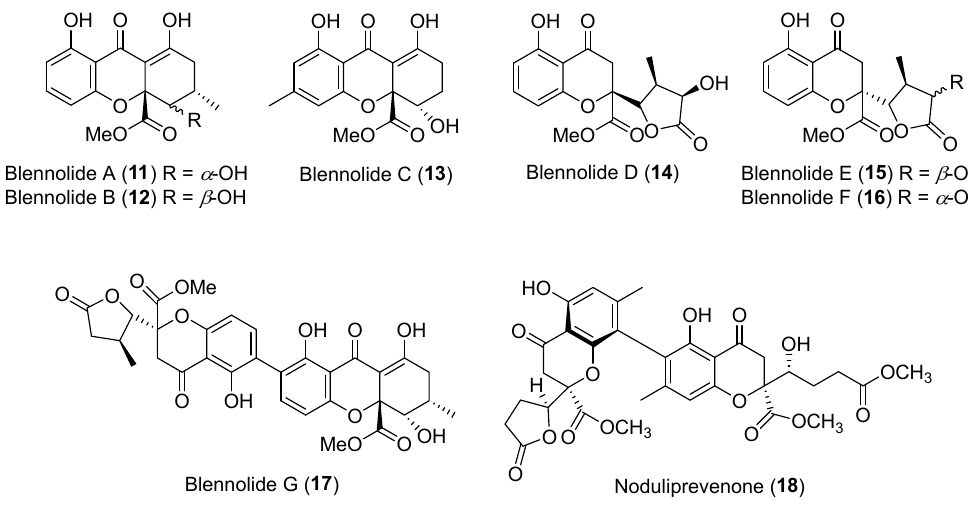
Figure 3. Structures of blennolides A–G ( 11 – 17 ) and noduliprevenone ( 18 ).